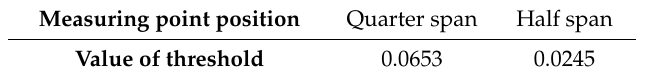
Table 4. COV threshold for automatic identification of Vortex-induced vibration (VIV).